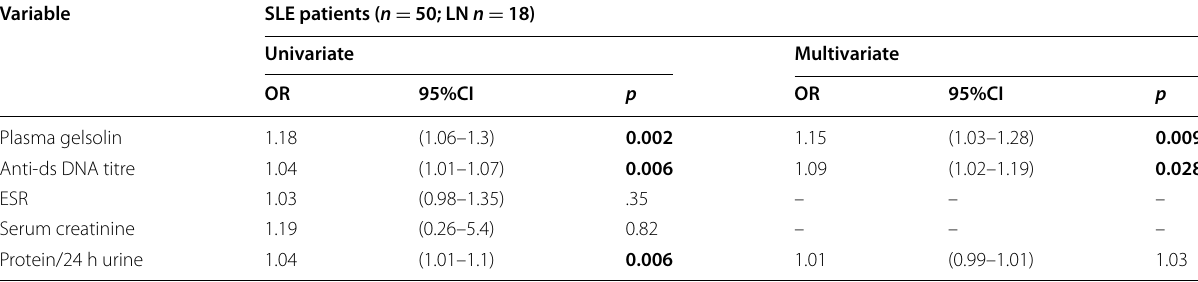
Bold values are significant at p